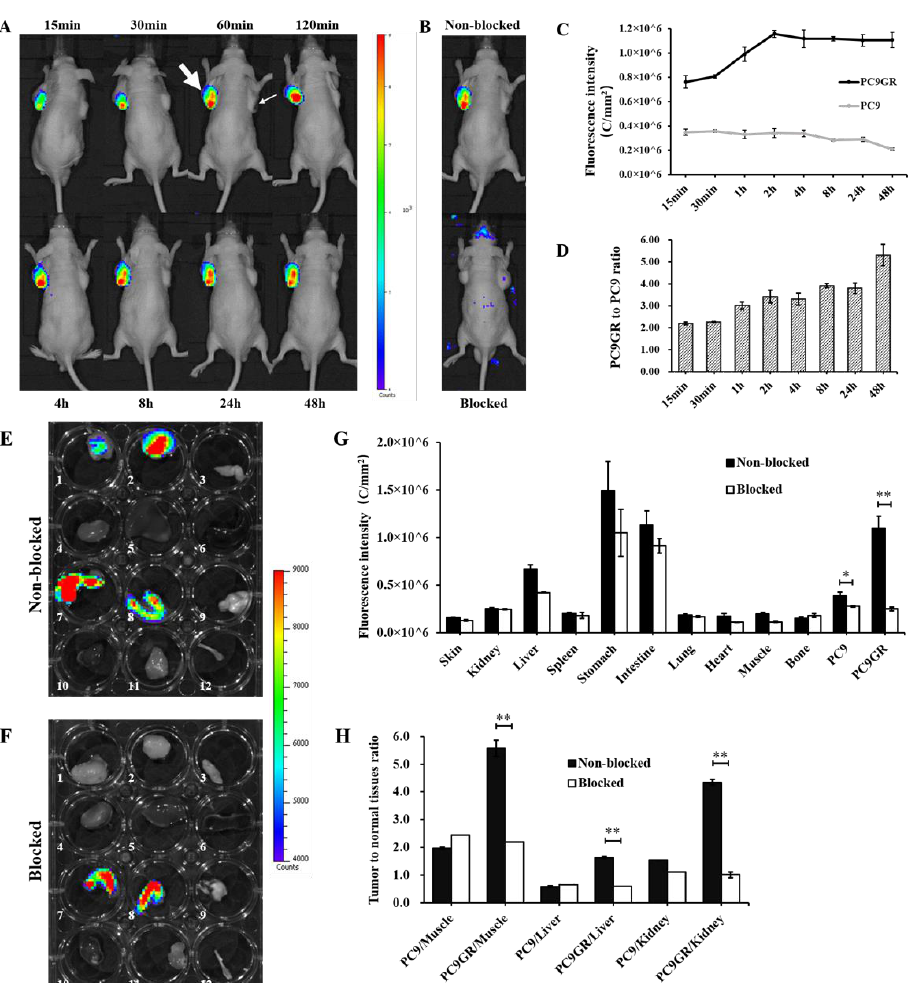
Figure 6. ( A ) Dynamic fluorescence imaging in vivo of Cy7-ADH-1 after intravenous administration (thick arrow: PC9GR tumor, thin arrow: PC9 tumor). ( B ) Fluorescence imaging of mice in non-blocked group and blocked group 1 h p.i. of Cy7-ADH-1. ( C ) Fluorescence intensity of PC9GR and PC9 at different time points after Cy7-ADH-1 injection in tumor-bearing mice. ( D ) PC9GR to PC9 ratios at different time points. In vitro imaging of tumors and major organs or tissues 48 h p.i. of cy7-ADH-1 in non-blocked group ( E ) and blocked group ( F ): 1 PC9 tumor, 2 PC9GR tumor, 3 skin, 4 kidney, 5 liver, 6 spleen, 7 stomach, 8 intestine, 9 lung, 10 heart, 11 muscle, 12 bone. Biodistribution of fluorescence intensity ex vivo of tumors and major tissues in non-blocked and blocked group ( G ) and ratio of tumor to normal tissues ( H ) based on ROI analysis. (* p < 0.05, ** p <